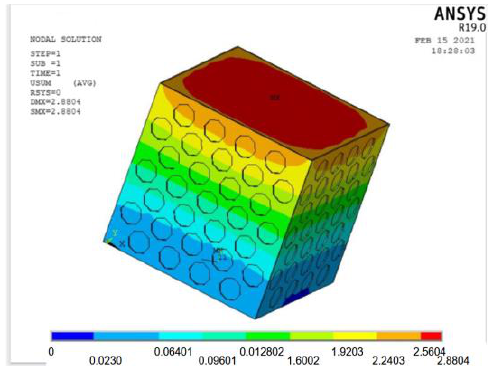
Figure 16. Strain nebula of perforated steel plate reinforced concrete model.